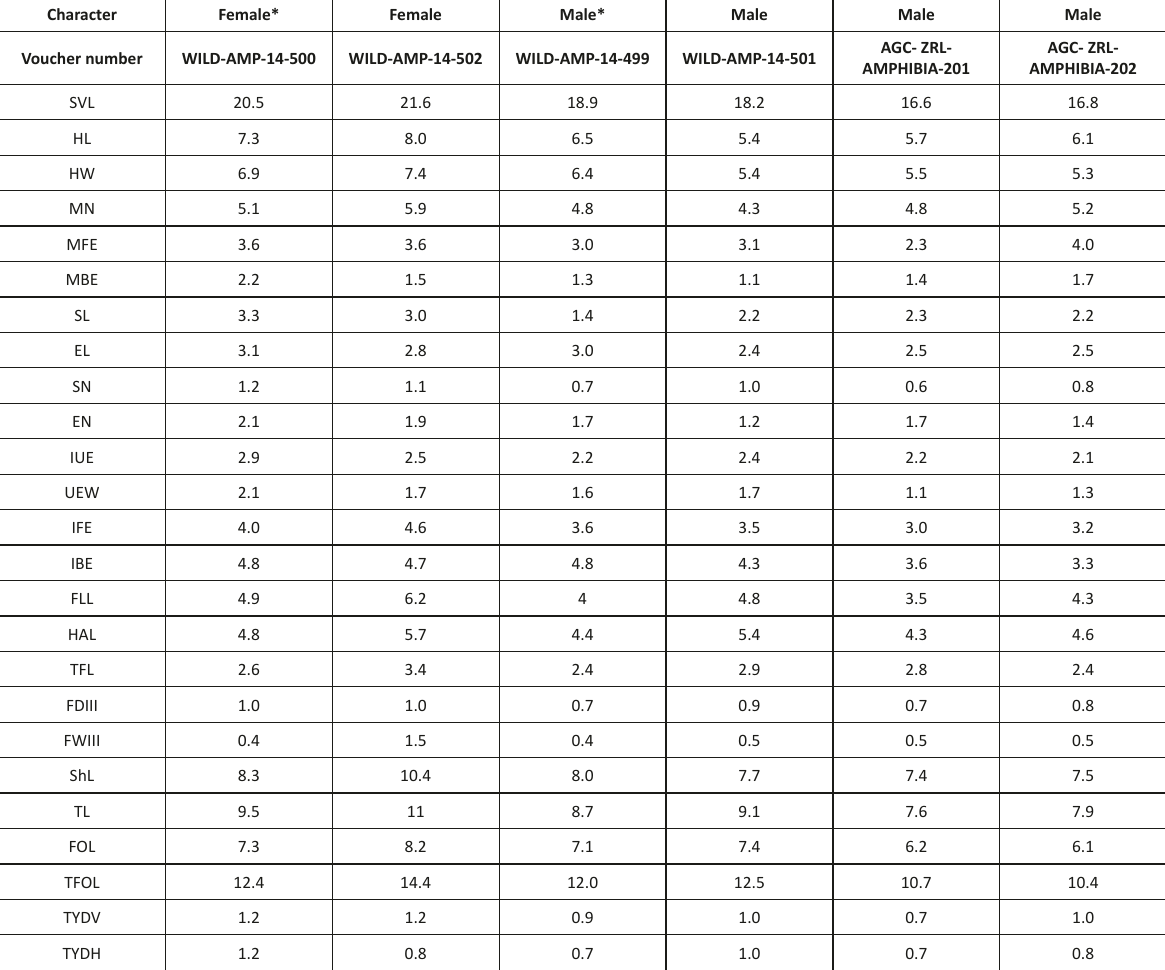
Table 2. Morphometry (in mm) of four males and two female specimens of Raorchestes tuberohumerus collected from Madikeri-Sakleshpura road. Character Female* Female Male* Male Male Male Voucher